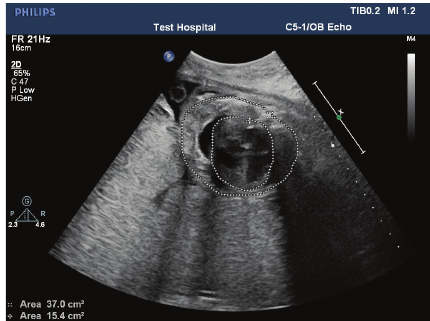
Figure 1: Four-chamber view of the fetal heart with increased cardi- othoracic